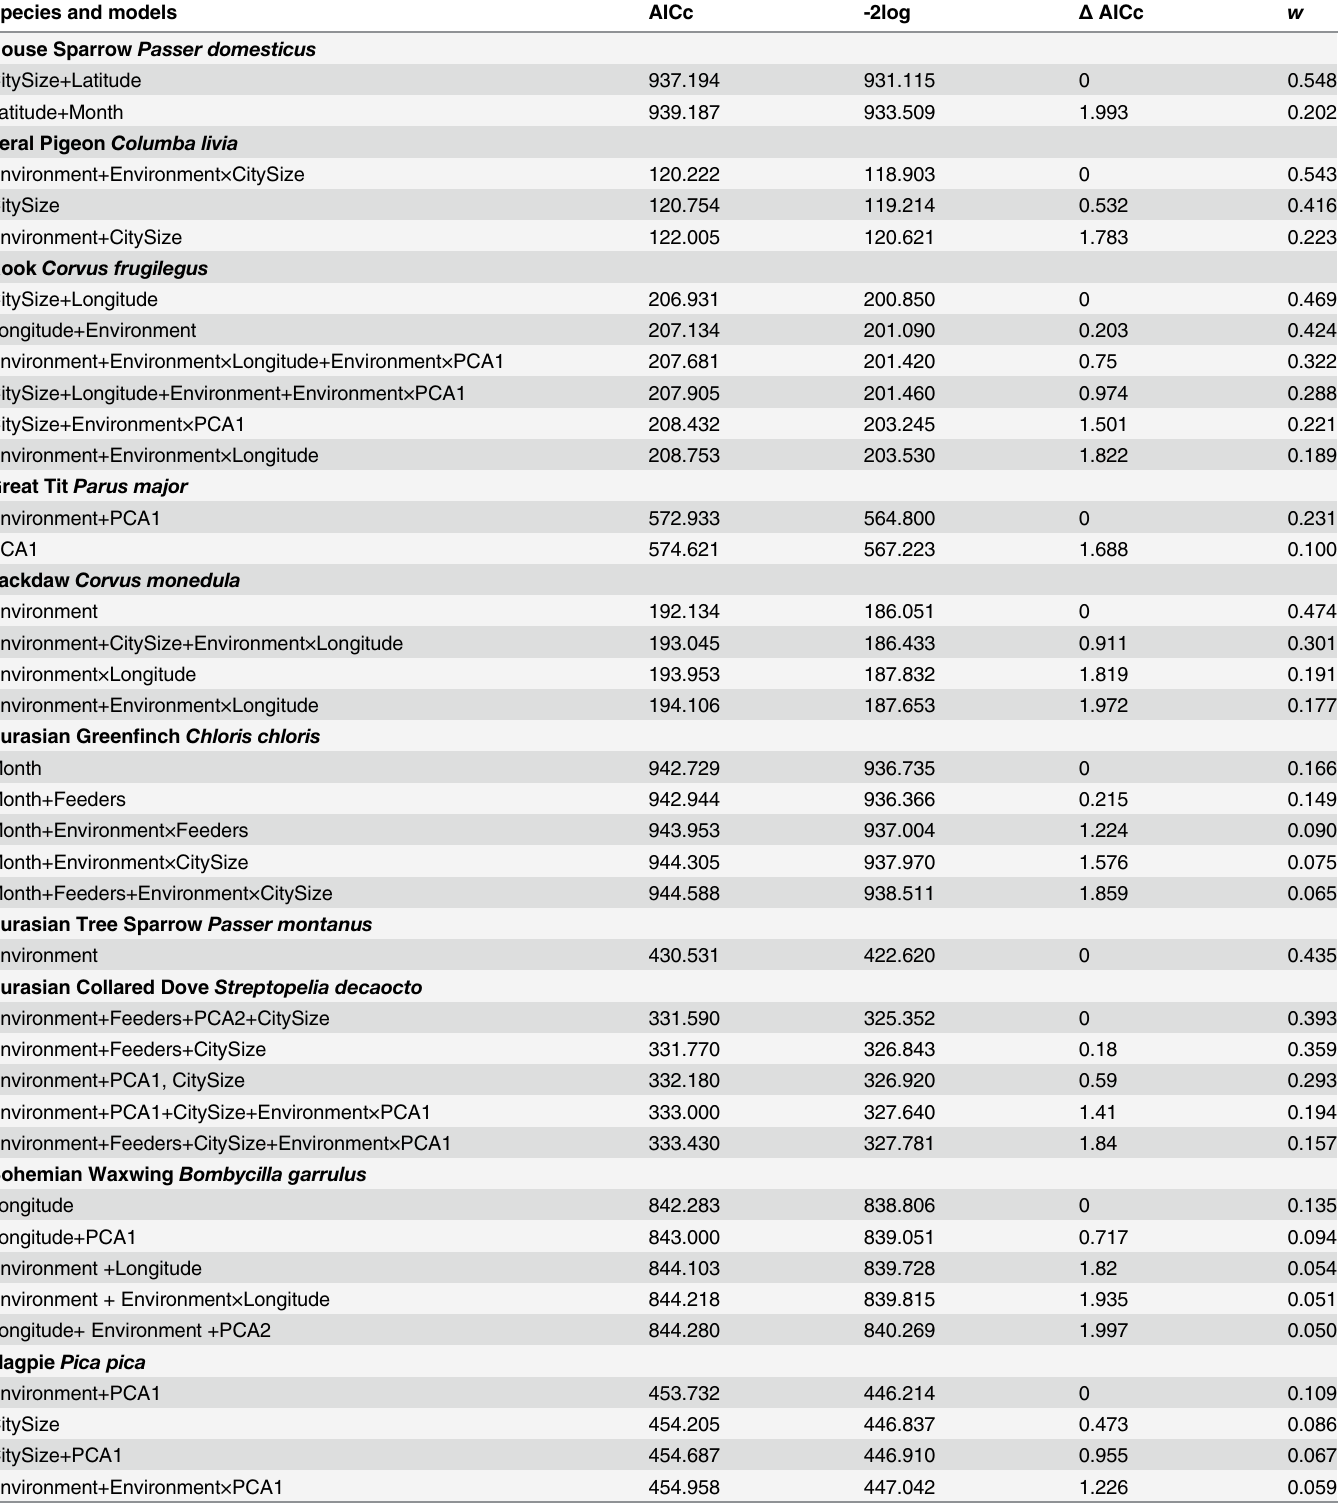
Table 5. Best generalized linear mixed models (GLMM) describing the abundance of the 10 most numerous bird species during the winter. Species and